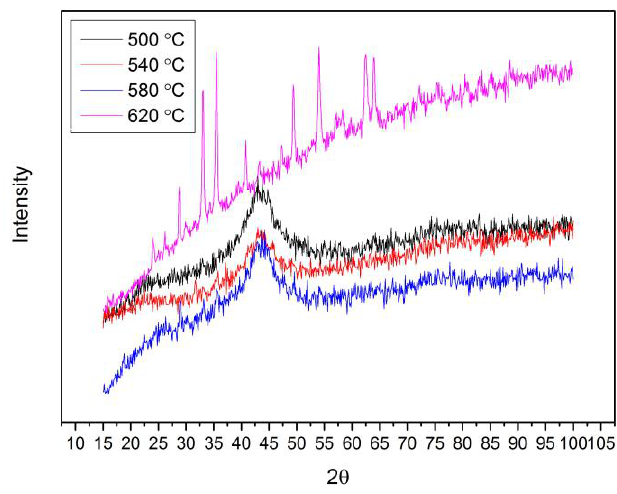
Figure 6. XRD patterns of sintered parts prepared at different sintering temperatures.